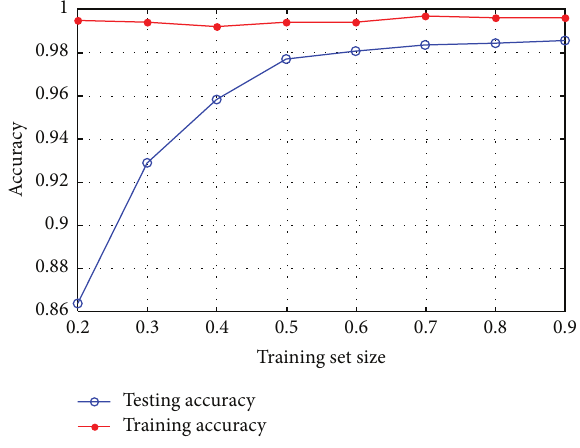
Figure 6: Cross-validation results.